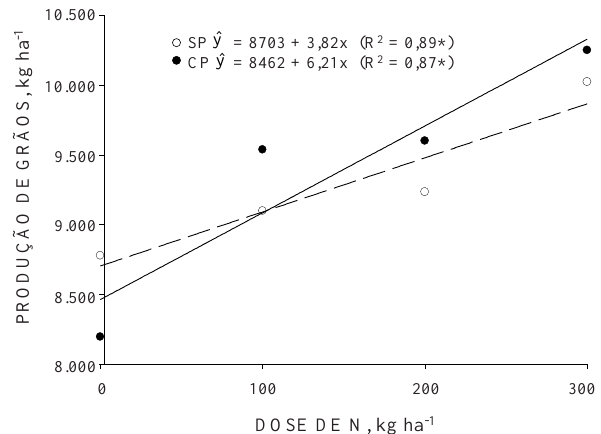
Figura 4. Produtividade de grãos de milho de acordo com as doses de nitrogênio aplicadas no inverno (N-TI), nas áreas Sem Pastejo (SP) e Com Pastejo (CP), Guarapuava (PR) 1999/ 2000.